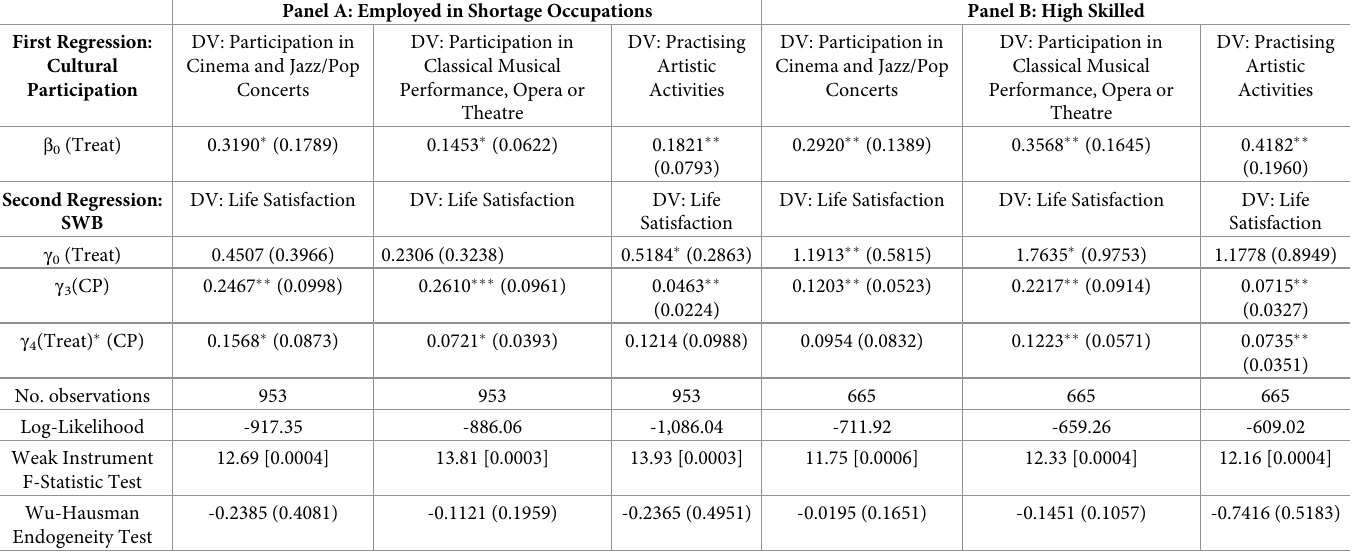
Table 9. FRDD estimates using a bandwidth of 4,000 €